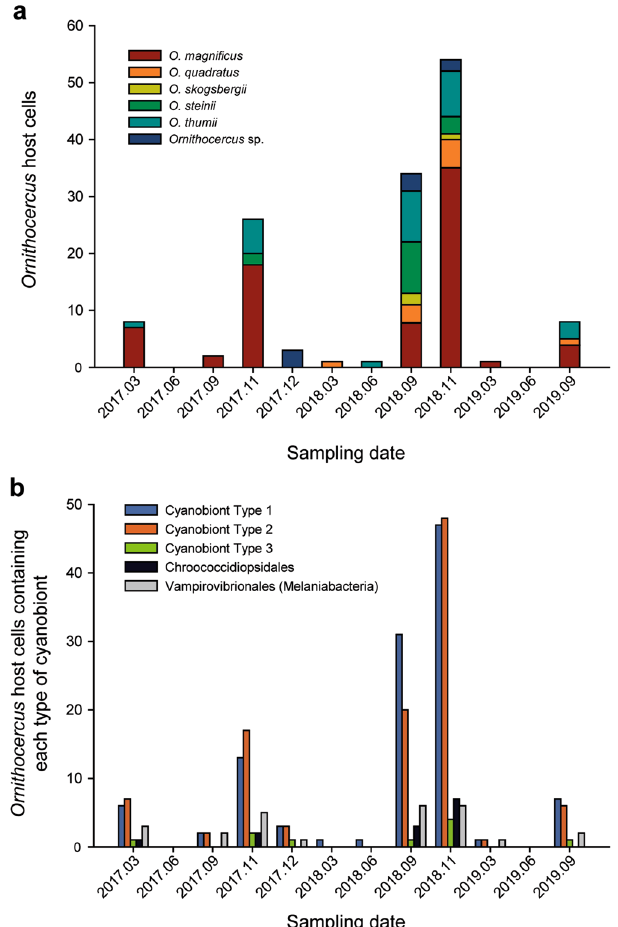
Figure 5. The number of individual cyanobiont-bearing Ornithocercus cells in temperate waters. ( a ) Seasonal changes in Ornithocercus populations showing the five host species and unidentified species encountered in the study areas. ( b ) The number of Ornithocercus hosts showing seasonal variations in symbiont